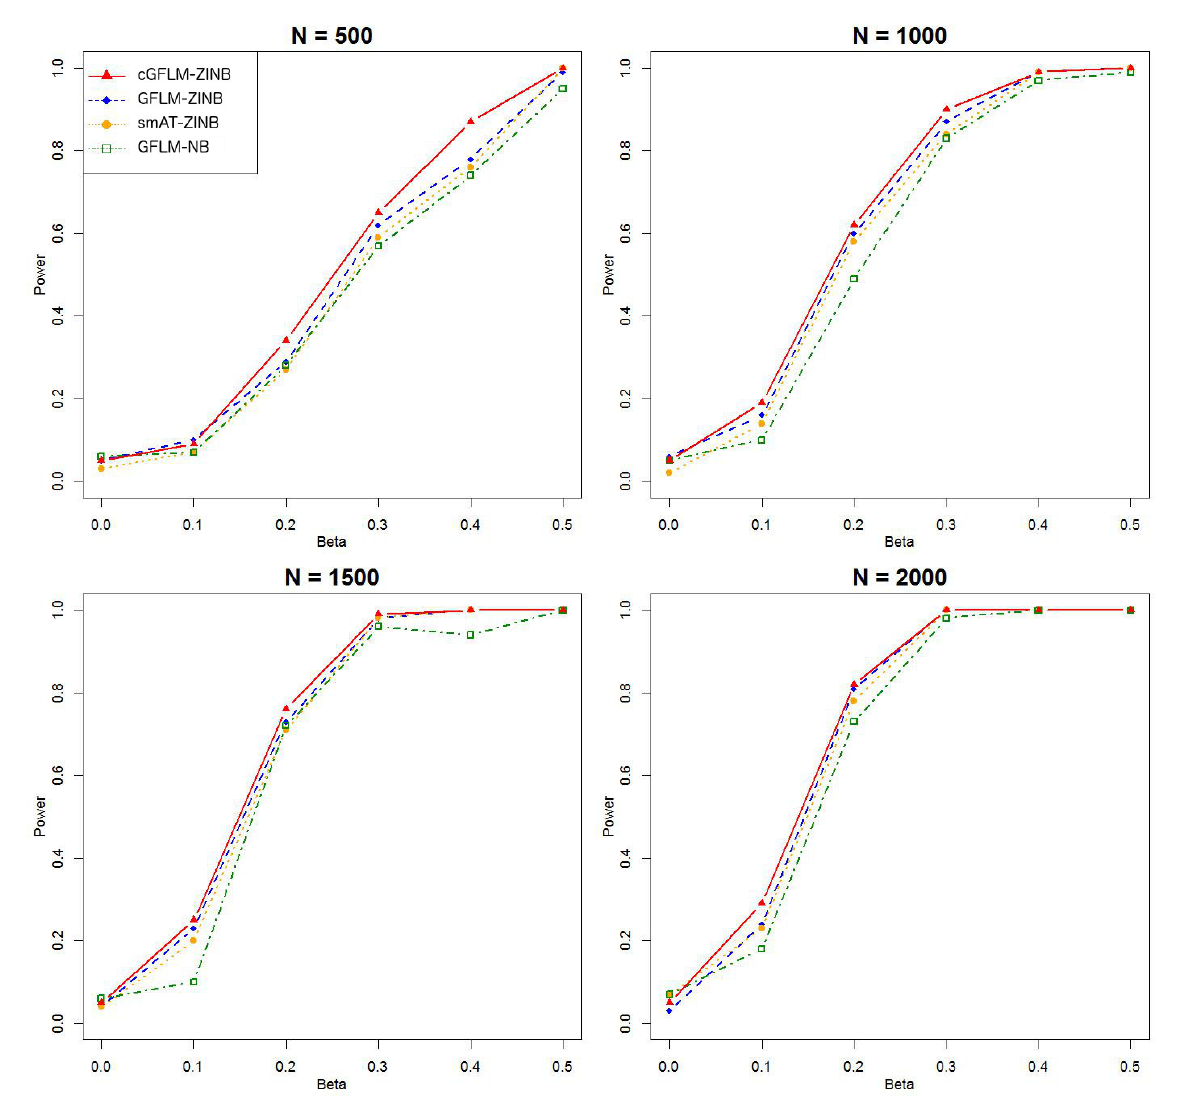
Figure A6. Power simulation for ZINB outcomes based on the CHRNA7 gene, two causal loci, effect in NB